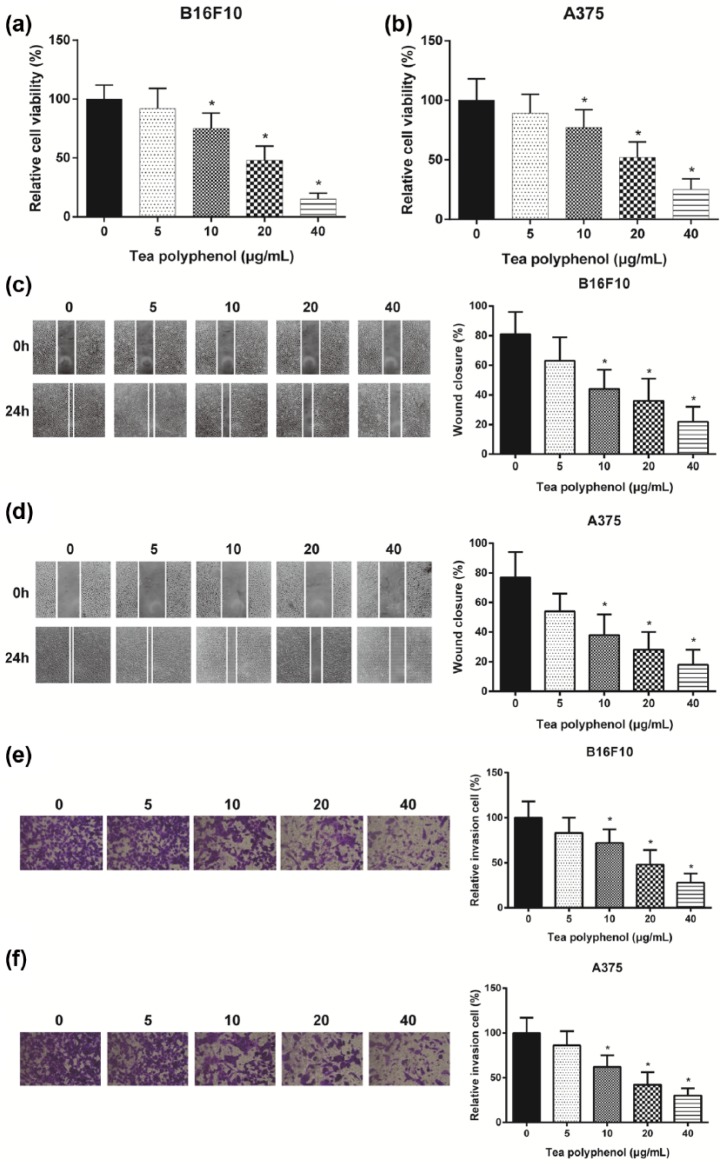
TP suppressed melanoma cells ability: (a and b) cell proliferation decreased
significantly as TP concentration grew by MTT assay. Cell viability
decreased significantly compared with non-TP group as TP concentration grew.
(c and d) Cell migration decreased significantly as TP concentration grew by
wound healing assay. Smaller wound closure was detected as TP concentration
grew, indicating fewer cells migration, and (e and f) cell invasion
decreased significantly as TP concentration grew by transwell assay. Less
invasion cells were detected in higher concentration TP group.*Significant difference compared with non-TP group with P < 0.05.